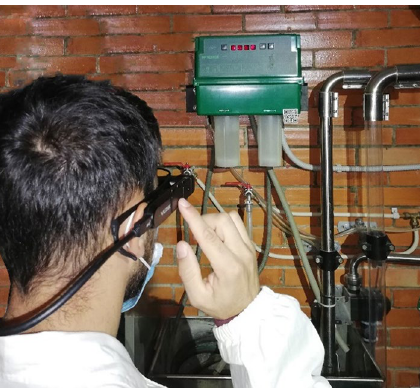
Figure 5. Operator with SG while accessing the maintenance augmented instructions through the QR code (40 mm), placed on the milking machine management control unit (green box).